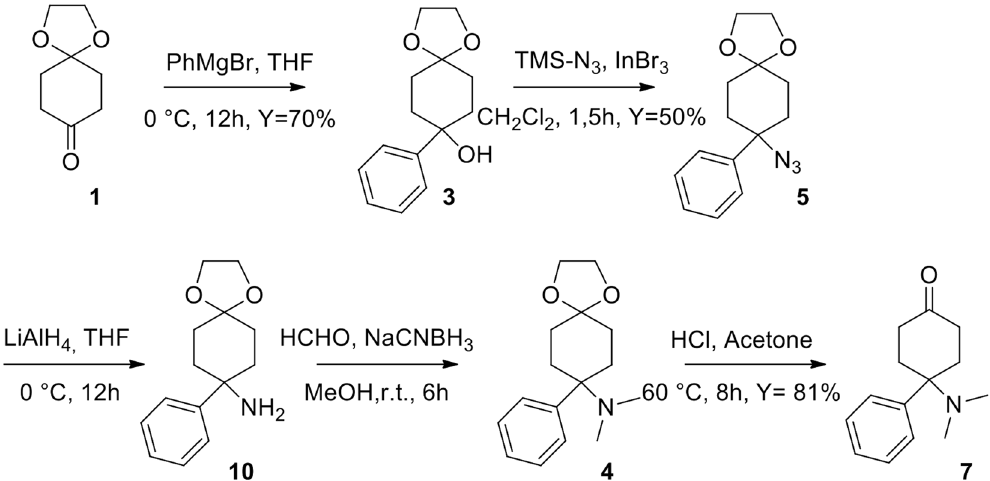
Figure 4. Synthesis of intermediate 7.